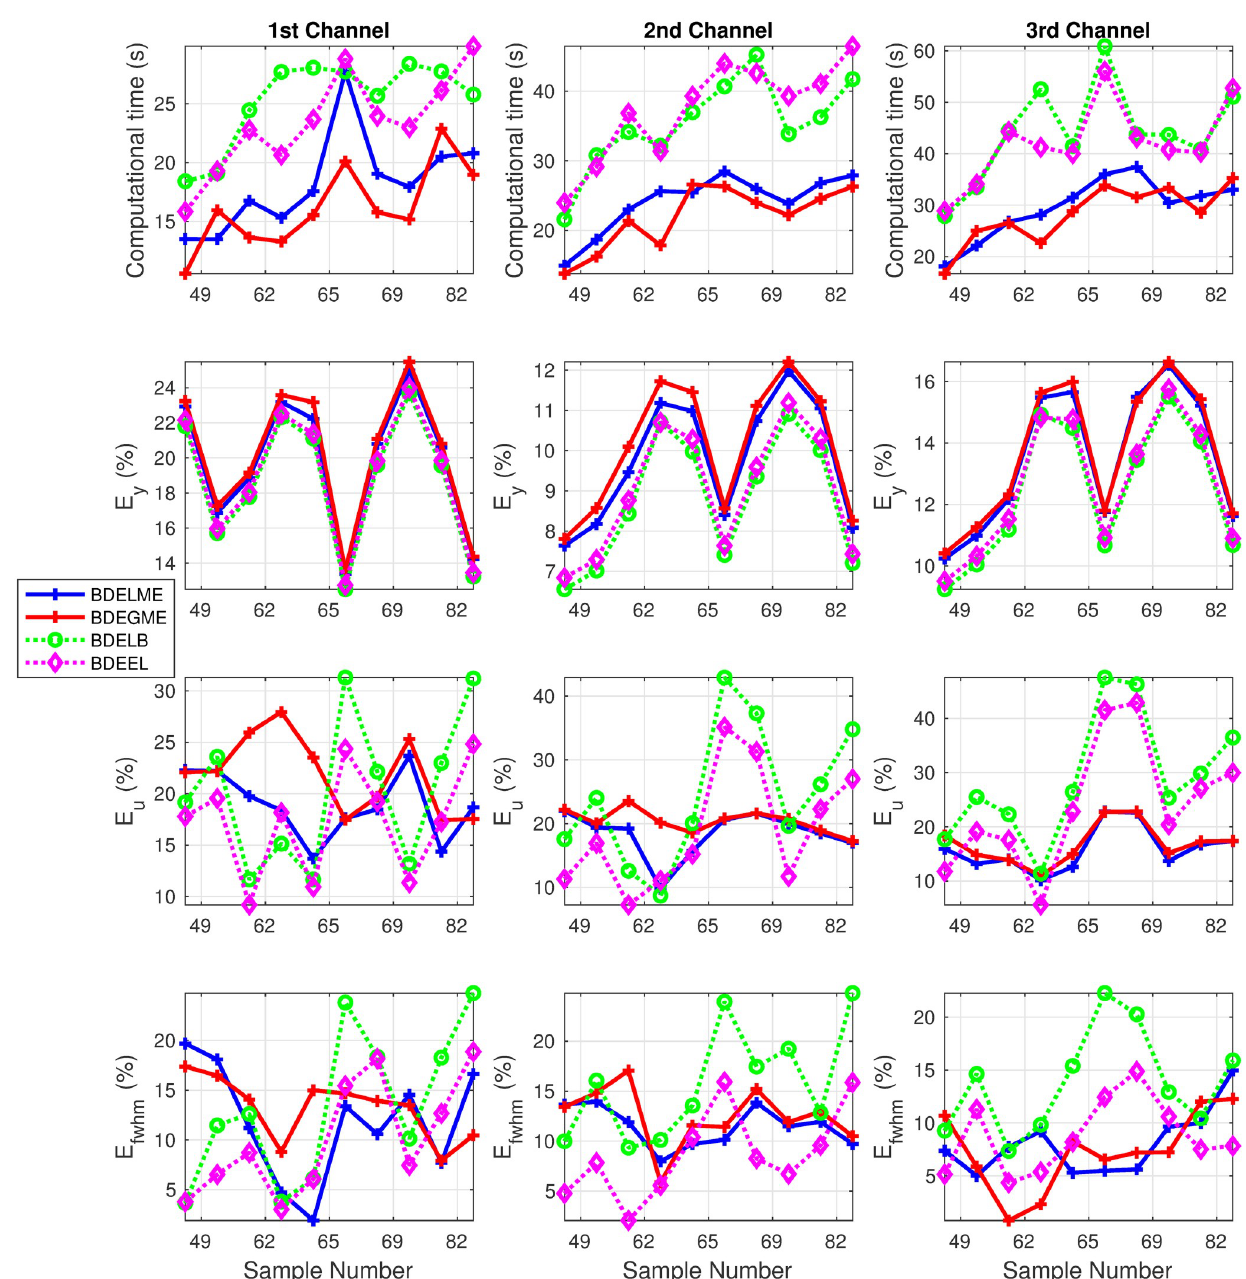
Fig 11. Performance metrics in experimental evaluation with lesion and normal samples for the three spectral channels: (top row) Computational time, (middle-top row) E y , (middle-bottom row) E u , and (bottom row) E fwhm